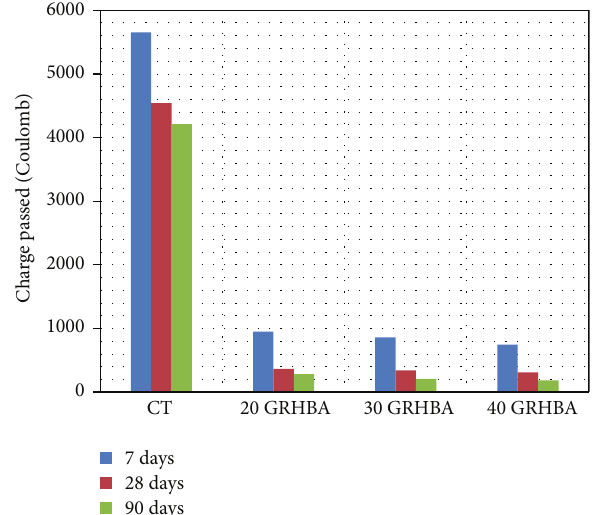
Figure 9: Chloride penetration of SCC with RCPT [11].